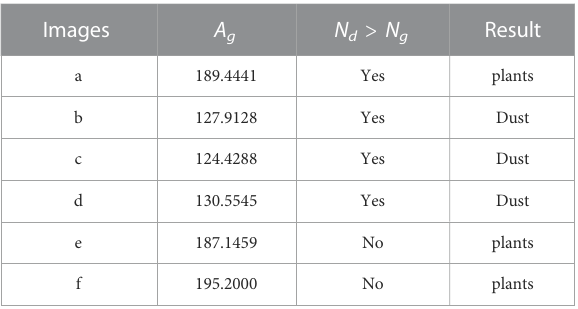
TABLE 3 Different image detection results.